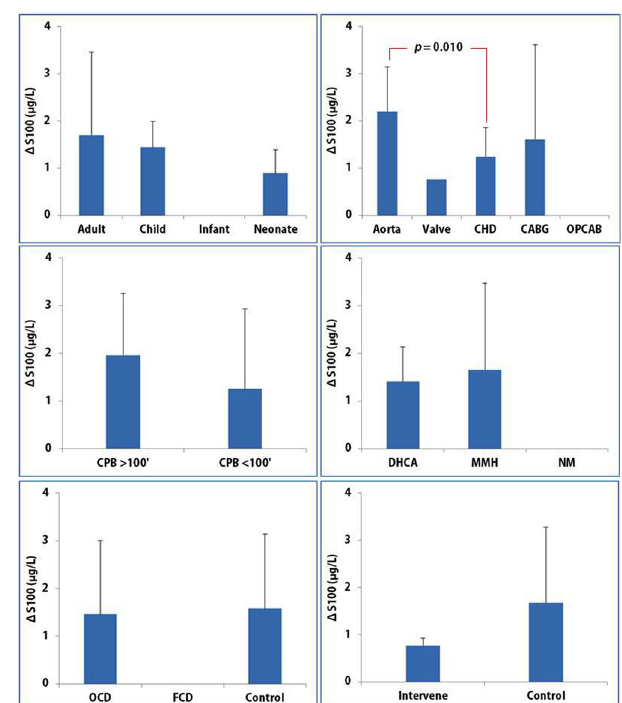
Fig. 2 - An inter-subgroup comparison of serum S100 at T and T . Fig. 3 - An inter-subgroup comparison of serum ΔS100 at T 2 7 CABG=Coronary artery bypass; CHD=Congenital heart defect; CABG=Coronary artery bypass; CHD=Congenital heart defect; DHCA=Deep hypothermia circulatory arrest; FCD=Functional DHCA= Deep hypothermia circulatory arrest; FCD=Functional cerebral damage; MMH=Mild-moderate hypothermia; cerebral damage; MMH=Mild-moderate hypothermia; NM=Normothermia; OCD=Organic cerebral damage; OPCAB=Off- NM=Normothermia; OCD=Organic cerebral damage; OPCAB=Off- pump coronary artery bypass; T =At the end of cardiopulmonary pump coronary artery bypass 2 bypass; T =24 hours after cardiopulmonary bypass 7